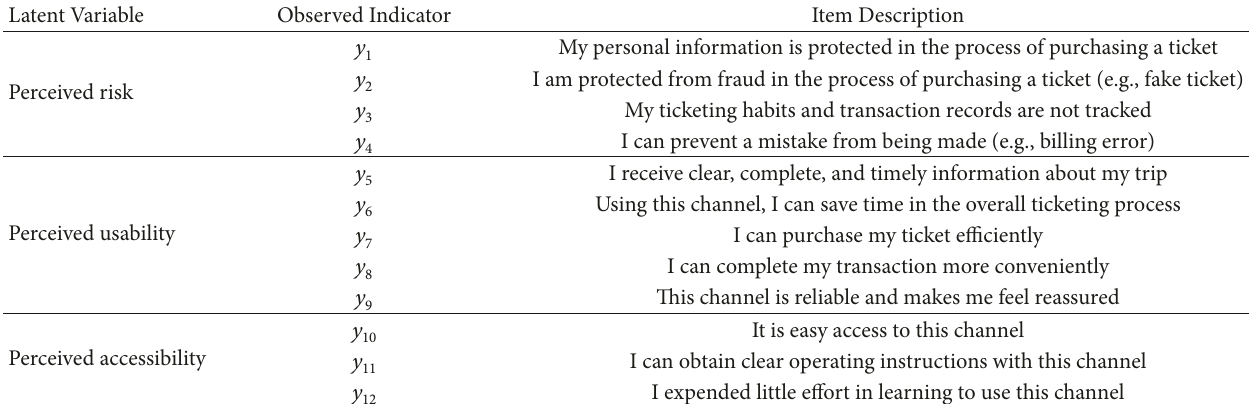
Table 1: Measurement items of latent